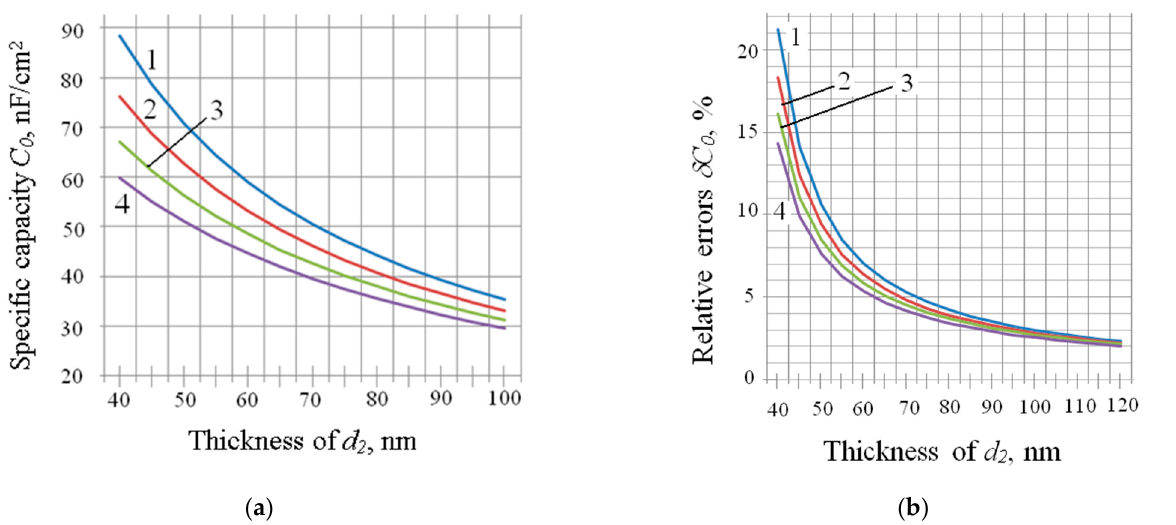
Figure 3. ( a , b ) are dependences C 0 ( d 2 ) and δ C 0 ( d 2 ) at d 1 : 1 → 0 nm; 2 → 40 nm; 3 → 80 nm; 4 → 120